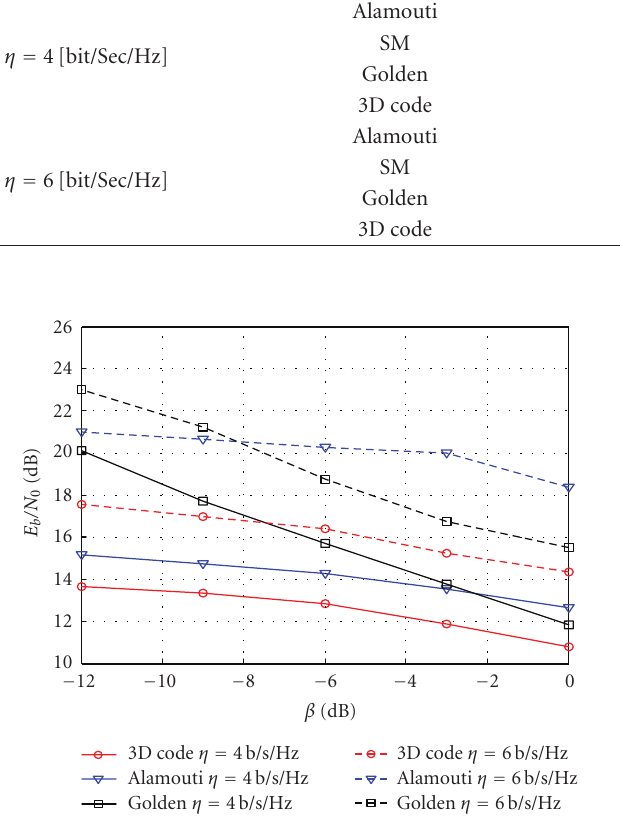
Figure 8: Required E b /N 0 to obtain a BER = 10 − 4 , double-layer case, η = 4b/s/Hz, η = 6b/s/Hz, TU-6 channel.